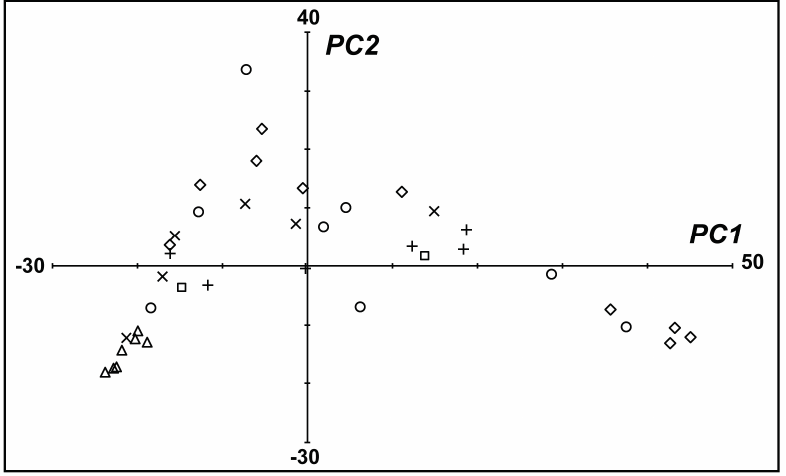
Figure 2. PC1 vs. PC2 Eigenvector values of flower volatile values from chrysanthemum cultivars and wild relatives. Chrysanthemum wild relatives ( ◊ ); spider type (×); pompon